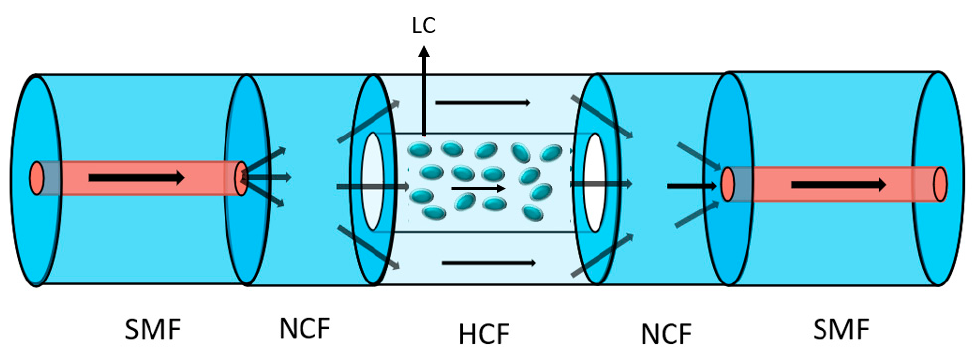
Figure 1. Configuration of LC filled NC-HC-NC structure based modal interferometer.